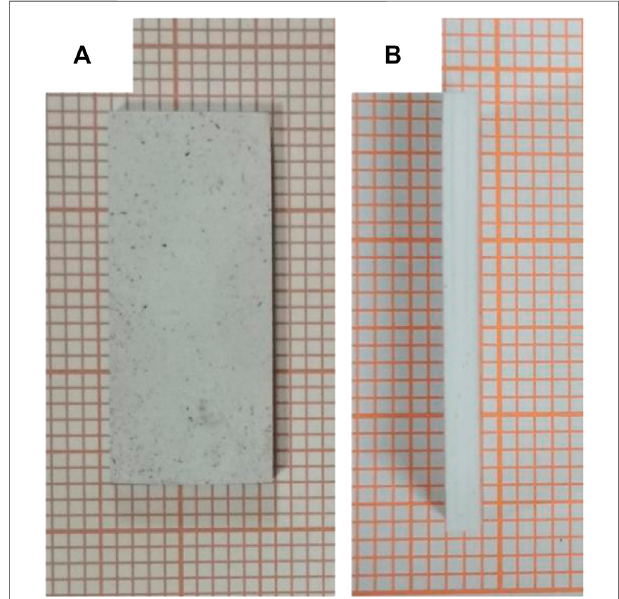
FIGURE 7 | Typical macromorphology of Si 3 N 4w /Si 3 N 4 : (A) surface of the 25 vol% Si 3 N 4w /Si 3 N 4 ; (B) section of the 25 vol% Si 3 N 4w /Si 3 N 4 .